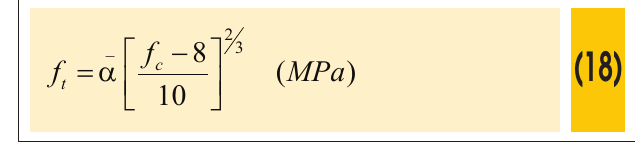
Figure 4 – The model by Ottosen 1977: tensile and compression